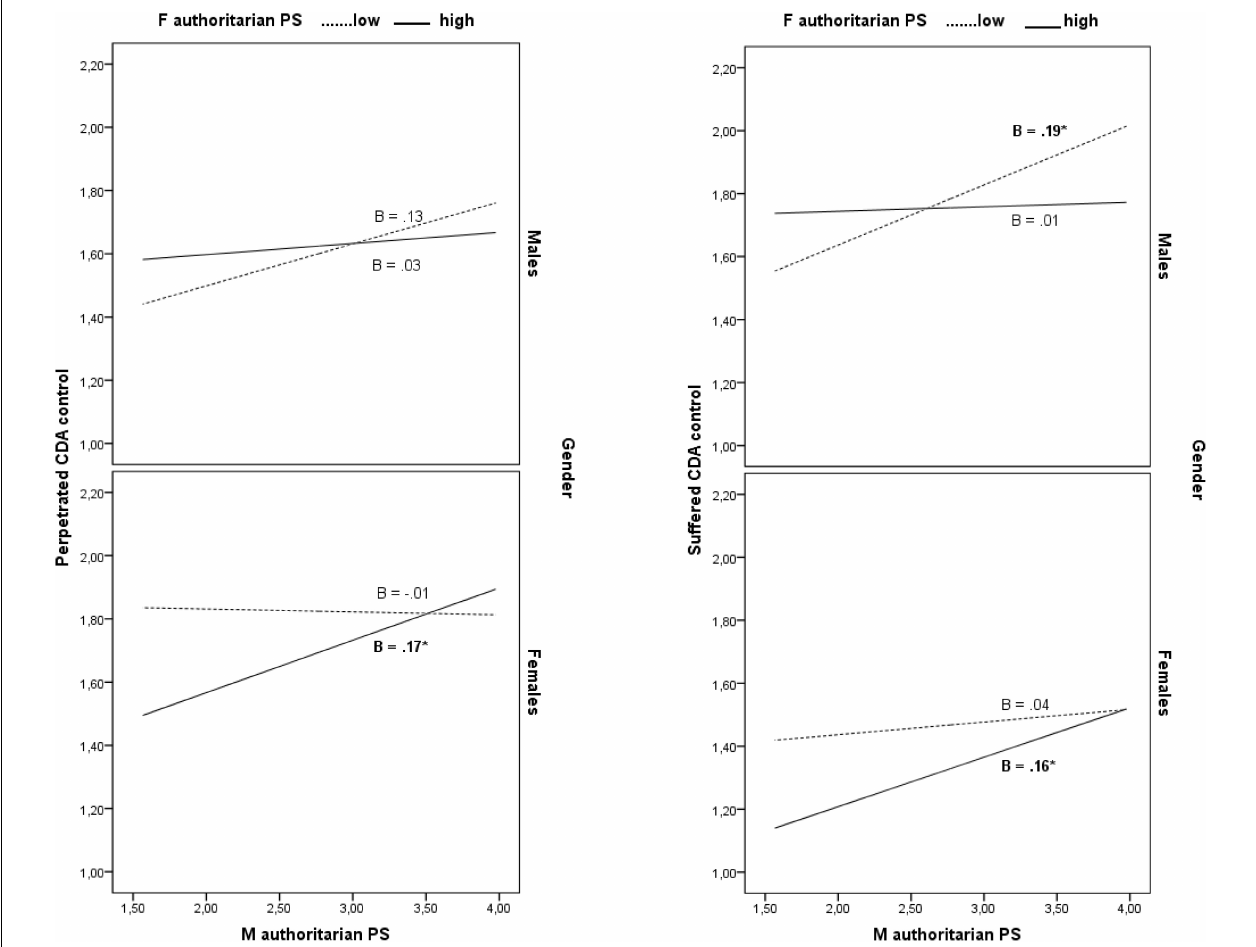
FIGURE 2 | The conditional effects of mother authoritarian parenting style on perpetrated and suffered cyber dating control as a function of father authoritarian parenting style and child gender. * p < .05. M, mother; F, father; PS, parenting style; CDA, cyber dating